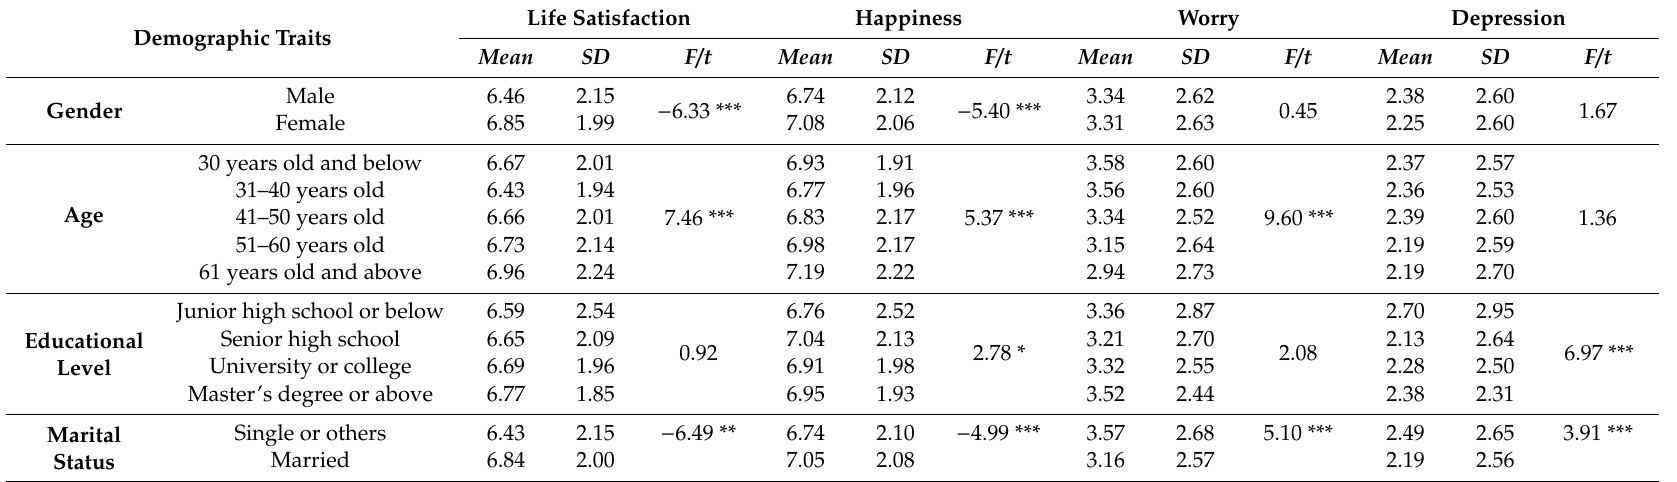
Table 3. Relationship between socio-demographic characteristics and emotional